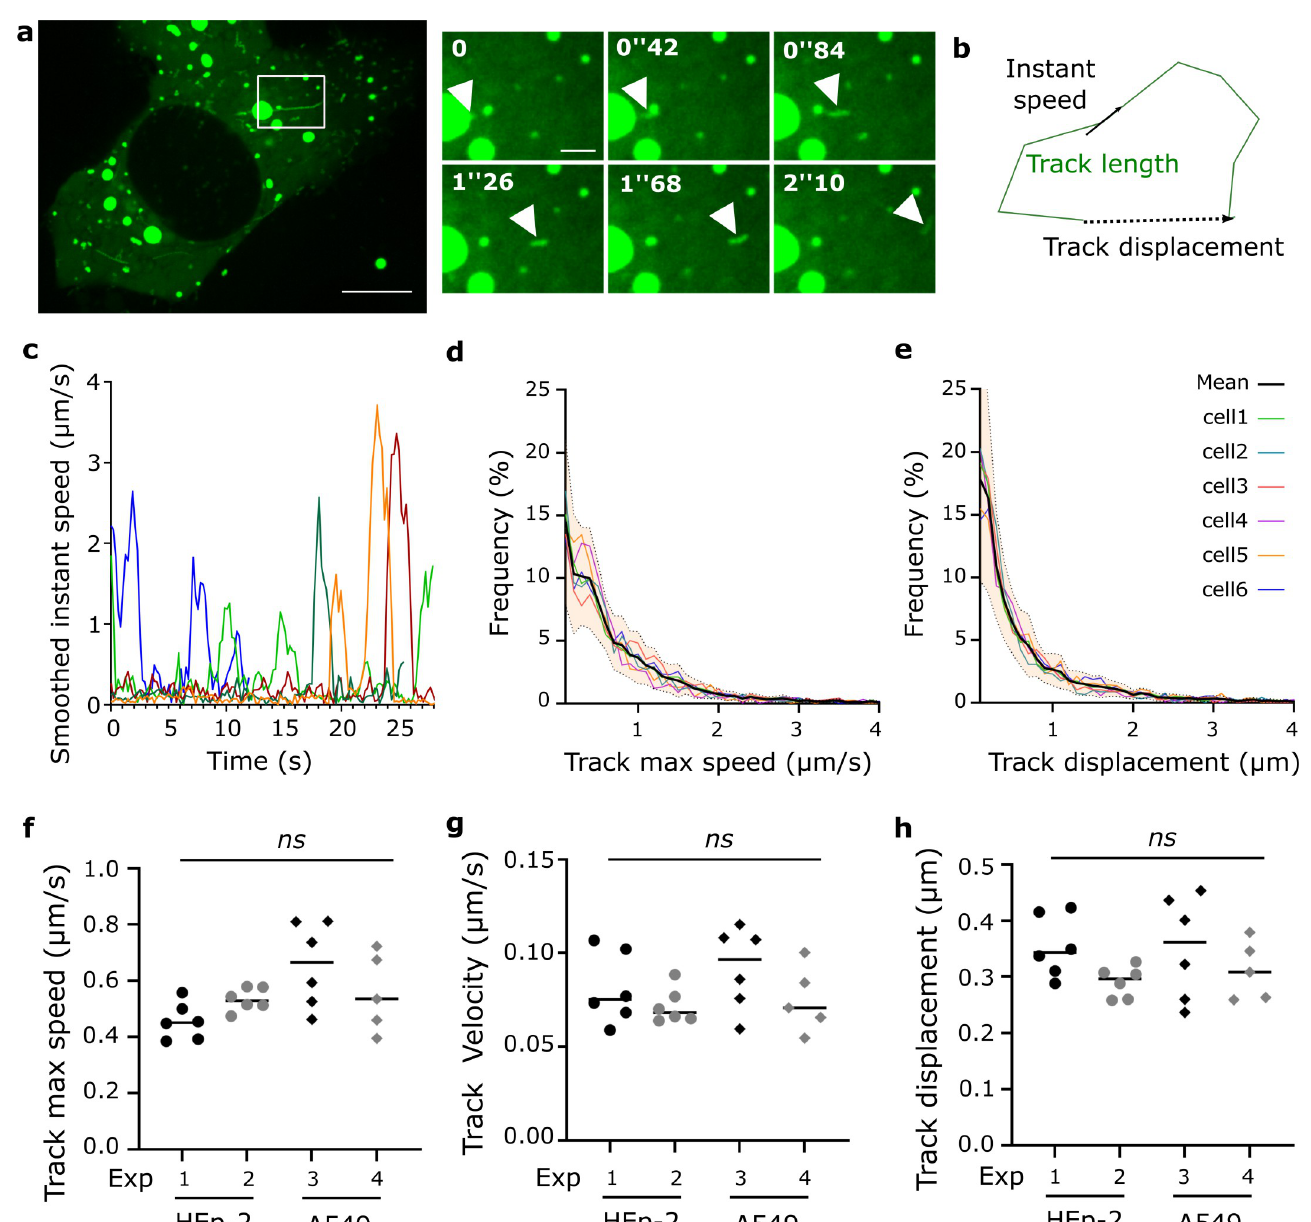
Fig 2. Characterization of RNP intracellular motions in RSV-GFP-N infected cells. Live images of HEp-2 or A549 cells infected with RSV-GFP-N for 18 to 20h are analyzed using Imaris software as described in methods section. a) Dynamic behavior of RSV RNPs in HEp-2 cells. Images stacks (3 z-steps) were processed as maximum projections and visualized after gaussian filter fixed at 0.5, the large view is a time projection of 12 consecutive frames (0.21 s between frames). Scale bar 10 μ m. The zoomed time series show a fast-moving RNP pointed by white arrow heads, scale bar 2 μ m. Representative images from 12 movies from 2 independent experiments are shown. b) Schematic illustration of the motion characterization parameters: instant speed (ratio between the minimal distance between two positions and time interval between these positions), track length (sum of the minimum distance between 2 consecutives positions for the whole track), track displacement (minimal distance between the first and the last position of the particle). c) Smoothed instant speeds of fast-moving particles plotted versus time from the first detection (each color represents one particle, representative examples). d, e) Cumulative distribution of track max speed and track displacement from 6 individual HEp-2 cells from one experiment. f, g and h) Each point is the median of track maximum speed, track velocity and track displacement from one individual cells. ns : No statistical difference between 4 independent experiments on HEp-2 and A549 cells using Brown-Forsythe and Welch’s ANOVA